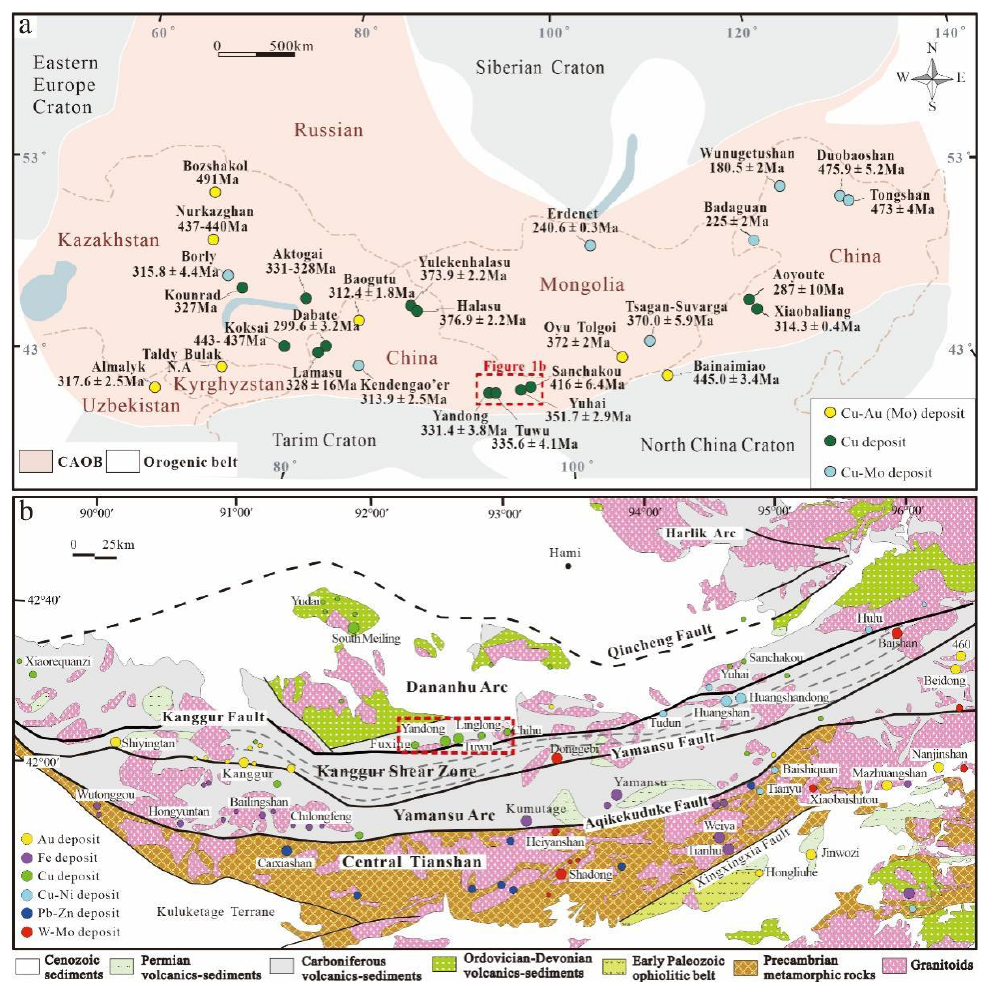
Figure 1. ( a ) Schematic map showing distribution of major ore deposits in the CAOB (modified from [11]). ( b ) Tectonic framework and distribution of deposits in the Eastern Tianshan (modified from [13]).